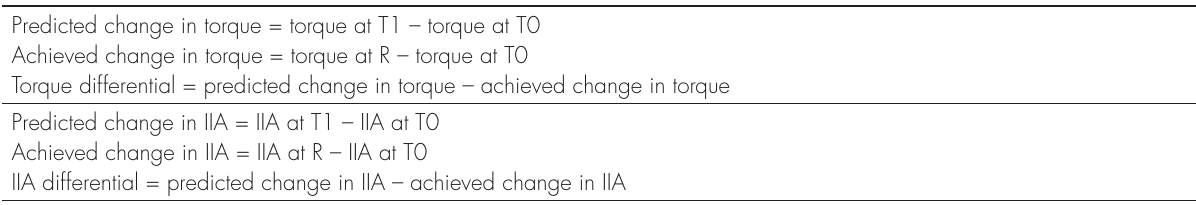
Table II. Calculation of torque, interincisal angle (IIA) differential and mean accuracy.